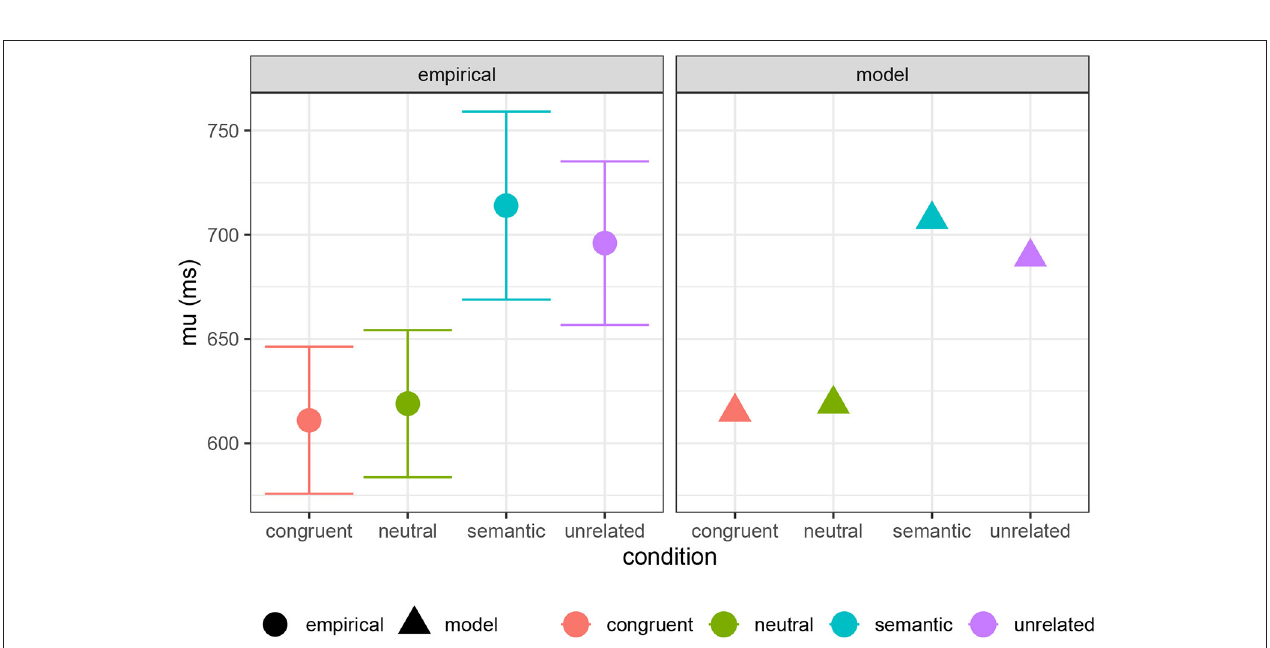
FIGURE 9 | Empirical mean RTs for PWI conditions from Roelofs and Piai (2017), compared with model predictions (see text). Error bars show 95% confidence intervals of the mean in the empirical data.